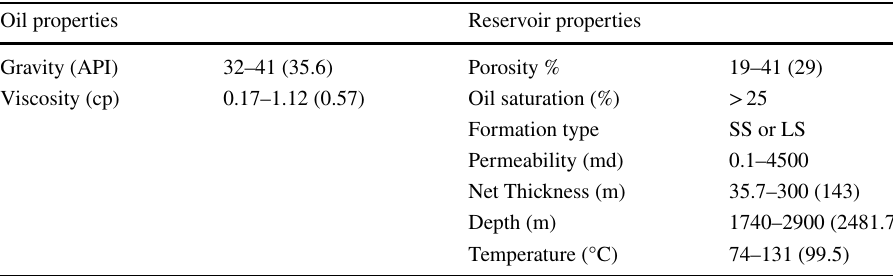
Fig. 4 Representation of API range for WAG projects Table 7 North Sea WAG